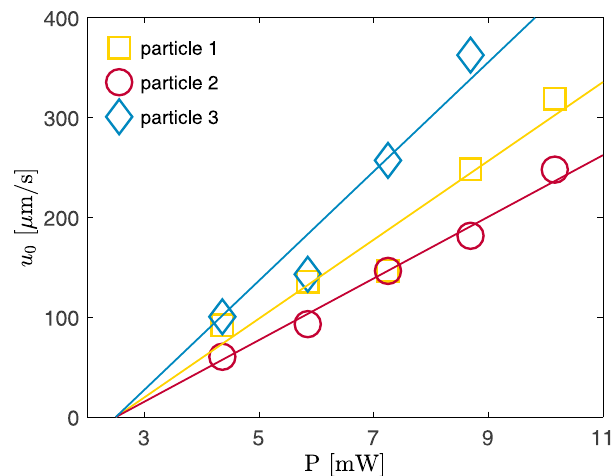
Fig. 5 Propulsion velocity as a function of the laser power. The values of the propulsion velocity u 0 as a function of the laser power P are obtained from fi ts like those shown in Fig. 2b, using Eq. (5). The solid line is given by u = C ( P − P P = 2.5 mW and C = 39.5, 30.9, and 54.7 ms − 1 mW − 1 0 c ), with c for particles 1 (yellow), 2 (red), and 3 (blue), respectively. The data of Figs. 2 and 3 are for particle